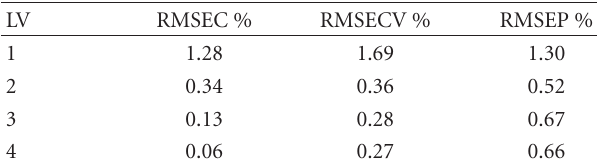
Table 3: Results for calibration model at 25 ◦ C.